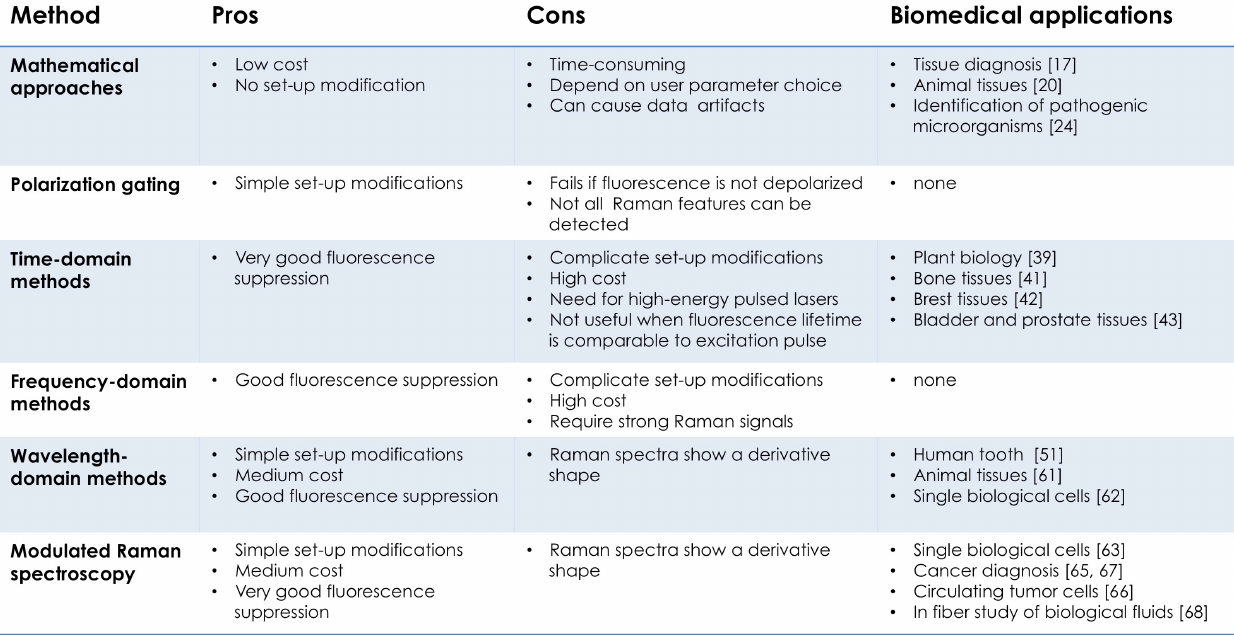
Table 1. Comparison between the presented fluorescence rejection methods in terms of advantages and